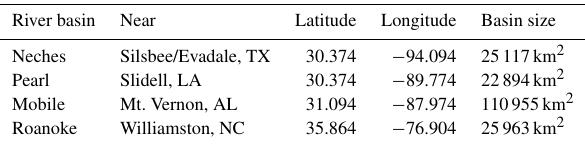
Table 1. Gage location in and size of the four study basins.